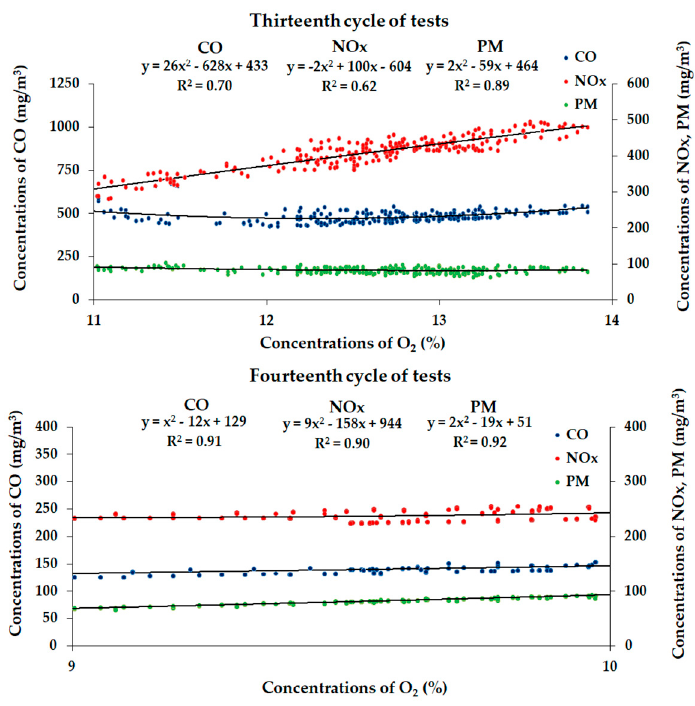
Figure 12. Mass distribution of harmful substances to the remaining amount of oxygen for the thirteenth and fourteenth cycle of tests.